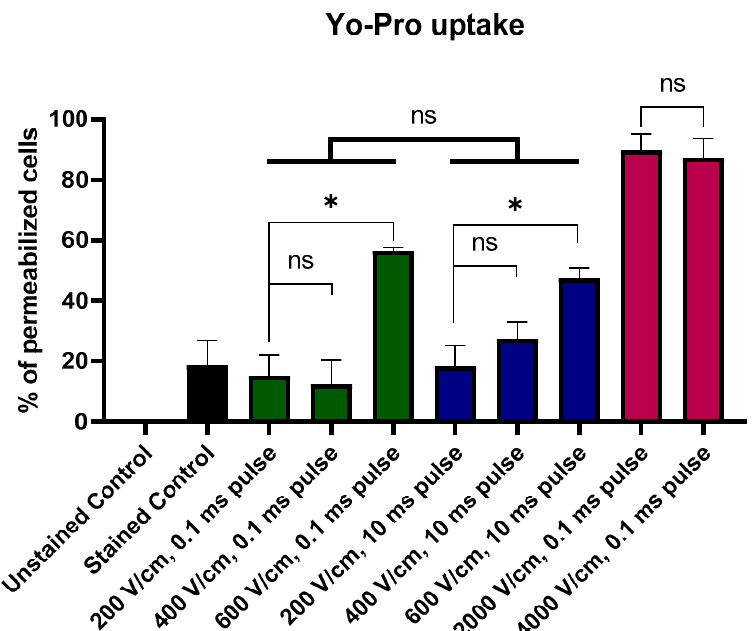
Figure 1. Permeability of melanoma cells as reported by the Yo-Pro uptake flow cytometry studies. Note that irreversible electroporation (IRE) protocols induce high-level permeabilization. Pulsed electric fields (PEFs) of lower intensities induce pulse-duration-dependent permeabilization. Black Bar represents control; green bars represent 200–600 V/cm, 0.1 ms pulses; blue bars represent 200–600 V/cm, 10 ms pulses; red bars represent 2–4 kV/cm, 0.1 ms pulses. Data presented as average ± SD. One-way ANOVA: * p < 0.05, ns p > 0.05.